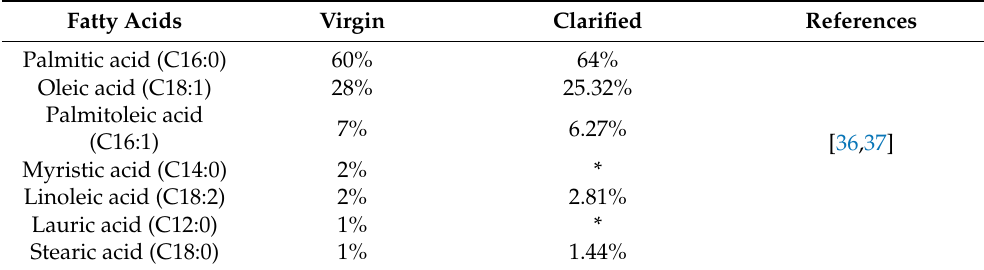
Table 5. Lipid composition of bacuri clarified butter obtained by pressing.